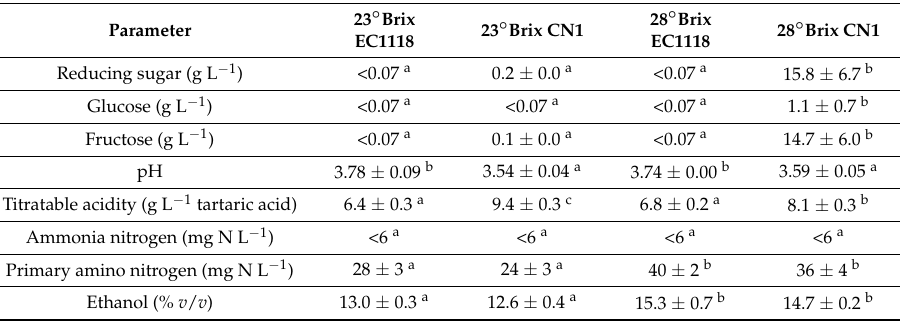
† n/d indicates the measurement is not detectable. Table 3. Chemical composition of Cabernet franc control wine (23°Brix) and wine made from partially dehydrated grapes (28°Brix). Data represents the mean value ± standard deviation of duplicate measurements per sample (three winemaking replicates per treatment). Lowercase letters within the same parameter indicate differences between treatments (Fisher’s Protected LSD 0.05 ).